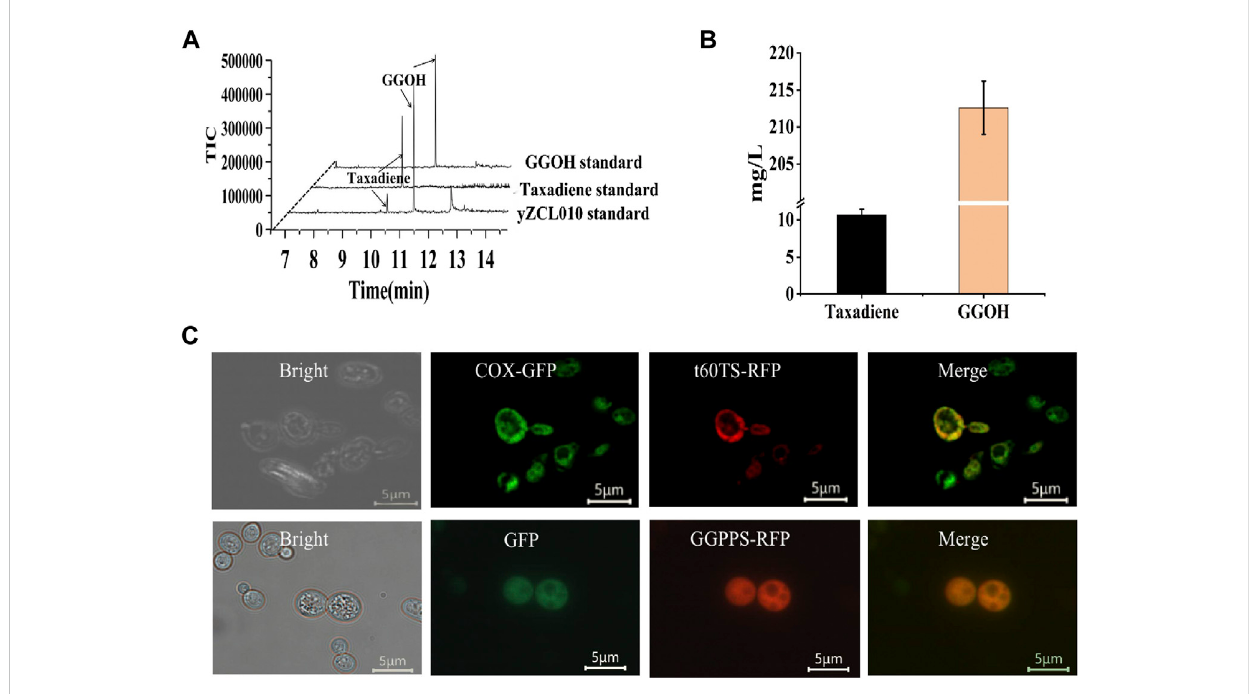
Construction of the initial taxadiene production strain and subcellular localization of key exogenous enzymes. (A) GC-MS results for the initial strain for taxadiene and GGOH production. The taxadiene and GGOH eluted at about 10.3 min and 11.3 min. (B) The titers of taxadiene and GGOH in